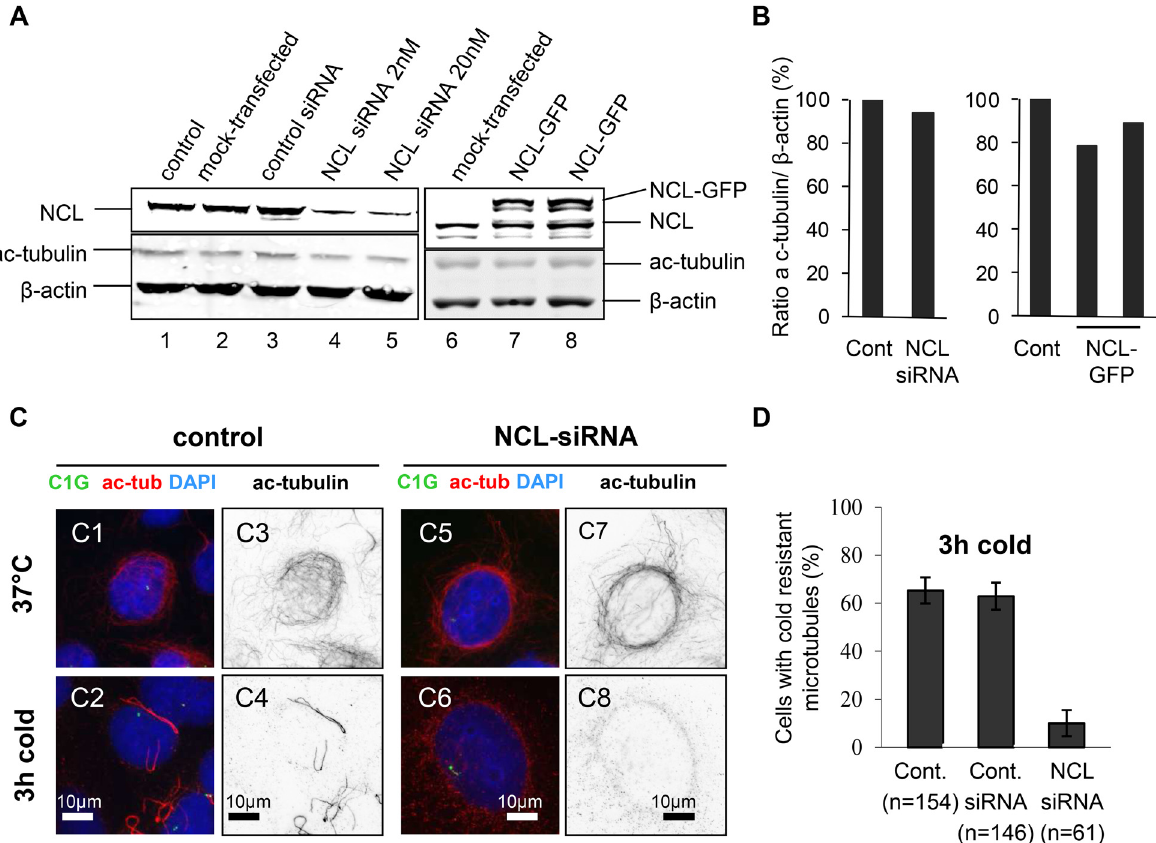
Fig 7. Loss of cold-resistant acetylated microtubules in nucleolin silenced cells. (A) Inhibition of nucleolin expression by siRNA. Western-blot analysis of whole cell extracts from untransfected control, mock transfected, control siRNA and nucleolin siRNA (siRNA concentration 2nM or 20nM) transfected cells. Cells were harvested four days after transfection and protein extracts were analyzed by western-blot using an anti- nucleolin polyclonal antibody (secondary antibody coupled to IRdye800) and acetylated tubulin (ac-tubulin) and β -actin monoclonal antibodies (secondary antibody coupled to Alexa680). (B) Quantifications of the fluorescent western blots, displayed in (A), expressed as a ratio of ac-tubulin over β -actin. The normalized expression level of acetylated tubulin was set to 100% in control cells (NCL siRNA 94.22% / NCL-GFP: 78.75% and 89.32%). (C) Microtubule regrowth after cold induced depolymerization in untransfected control and nucleolin siRNA transfected U2OS-centrin-1-GFP cells. Co-visualization of acetylated tubulin (ac-tub), centrin-1-GFP (C1G) and nuclear counterstain (DAPI) shown as 3-color merged image and black and white images of acetylated tubulin (inverted dynamics), before depolymerization first row), and immediately after depolymerization (second row). Centrin-1-GFP detection was enhanced with a GFP booster [green], acetylated tubulin was detected with a monoclonal antibody (secondary antibody coupled to Alexa555) [red on the 3-color merged images and black on black and white images]. Scale bars represent 10 μ m. (D) Quantification of the percentage of cells incubated in cold for 3h (C2, C6) exhibiting microtubules resistant to depolymerization. These cell classes are displayed for untransfected control cells (Cont.), control siRNA transfected cells (Cont. siRNA) and nucleolin siRNA transfected cells (NCL-siRNA). The values are expressed as percentages of the total number n of the cells studied. Error bars represent the standard ffiffiffiffiffiffiffiffiffiffiffiffiffiffiffiffiffiffiffiffiffiffiffi p p ð 1 (cid:3) p Þ = n deviation from two independent experiments (standard deviation of Bernoulli experiments =